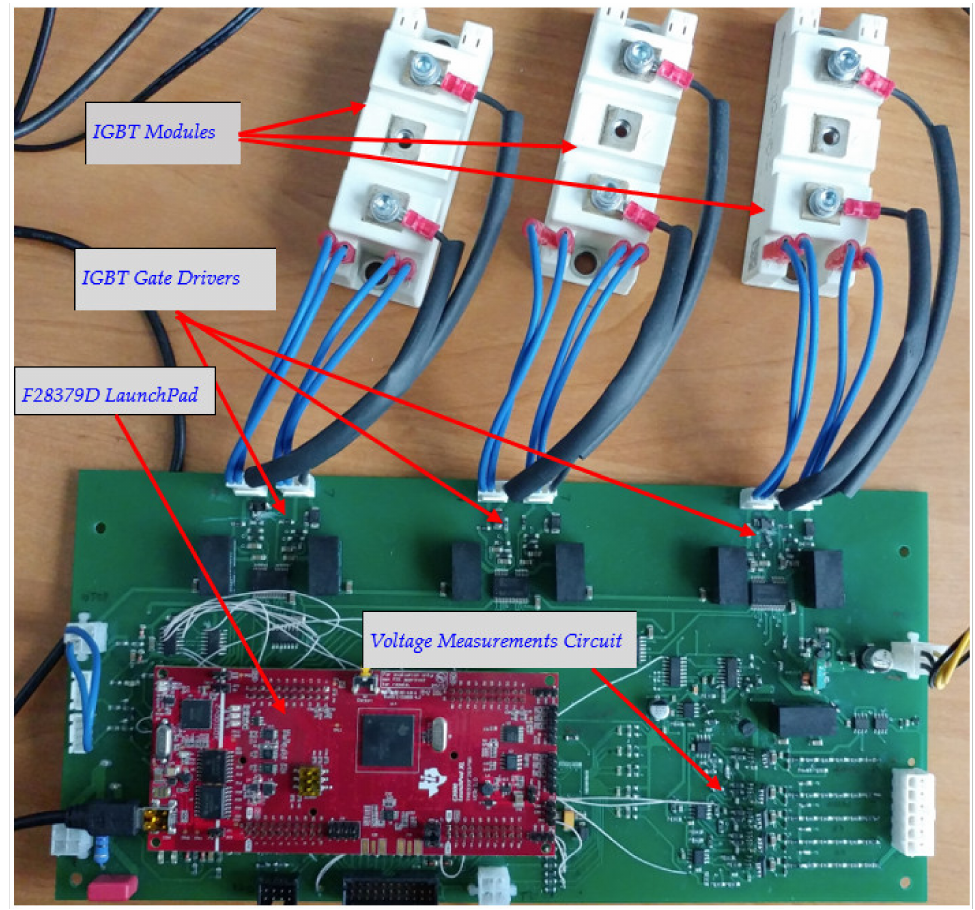
Figure 4. View of the APF control circuit during the development process (during desktop